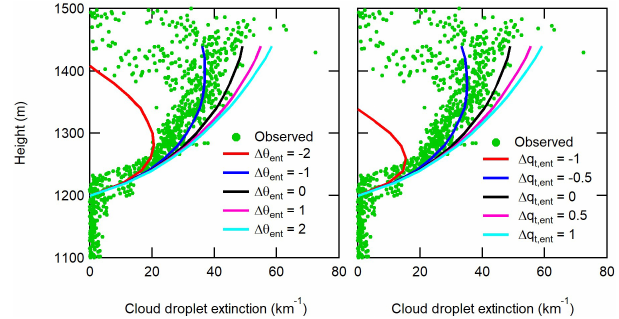
Figure 12. Sensitivity of simulated cloud extinction based on variability of entrained-air potential temperature ( θ ent , K) and entrained-air total water mixing ratio ( q t , ent , gkg − 1 ) for the C11Sc case. The (cid:49)θ ent and (cid:49)q t , ent terms define the change in the en- trained θ and q t values where no change ( (cid:49)θ ent = 0 and (cid:49)q t , ent = 0) is equivalent to the adiabatic simulation with entrainment from Fig.